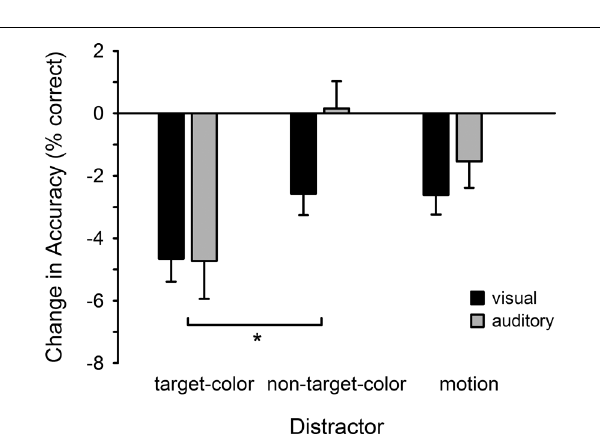
FIGURE 3 | Change in accuracy for detecting visual and auditory targets. Accuracy is plotted for each distractor condition relative to the baseline (no-distractor) condition. Changes in accuracy were identical for the visual and auditory tasks. * p < 0.05 (corrected for multiple comparisons). Error bars show within subjects